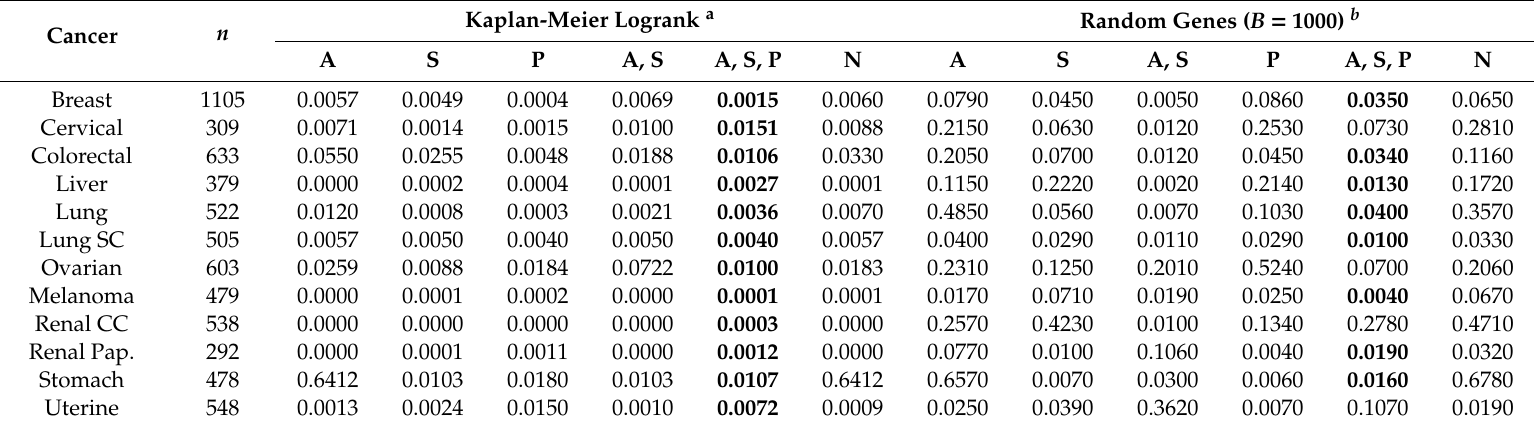
Table 3. Kaplan-Meier logrank test p -values for best principal component (best binarized PC) derived from correlation matrix of DNA repair genes with significant individual KM tests after adjustment of expression for age, stage, and PCNA metagene e ff ects. Cancers listed had both age at diagnosis and stage available in TCGA clinical